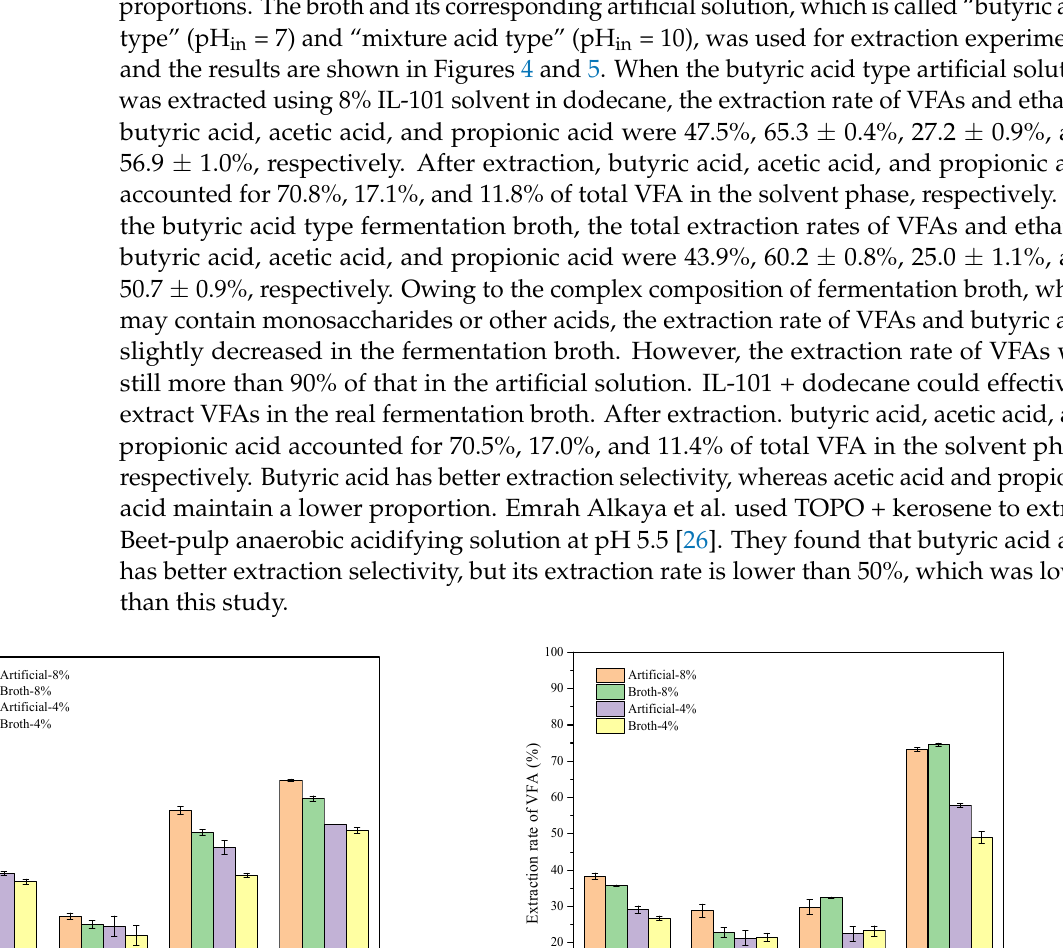
Figure 5. The composition of VFA in solvent phase after extraction. When the mixture acid type artificial solution was extracted using 8% IL ‐ 101 solvent in dodecane, the extraction rate of VFAs and ethanol, butyric acid, acetic acid, and propi ‐ onic acid were 38.4%, 73.3 ± 0.5%, 28.8 ± 1.9%, and 29.8 ± 2.1%, respectively. After extrac ‐ tion. butyric acid, acetic acid, and propionic acid accounted for 57.3%, 37.0%, and 3.9% of total VFA in the solvent phase, respectively. For the mixture acid type fermentation broth, the total extraction rate of VFAs and ethanol, butyric acid, acetic acid, and propionic acid were 35.7%, 74.6 ± 0.4%, 22.9 ± 1.3%, and 32.5 ± 0.1%, respectively. There was little loss of extraction efficiency in the fermentation broth. The extraction efficiency of butyric acid from real fermented broth was close to that in a previous report which used octanoic acid as extractant to extract single acid from artificial solution at pH 3 [39]. Compared with the butyric acid type fermentation broth, the extraction rate of total VFAs and ethanol from mixture acid type fermentation broth decreased by 17.9%, which may result from the higher concentration of VFAs and higher pH. However, the extraction rate of butyric acid was 1.4 times of that in butyric acid type fermentation broth. However, the proportion of acetic acid in the solvent phase reached 31.6%, whereas that of butyric acid decreased to 62.7%. This may be due to the higher concentration of acetic acid in broth, which was more than three times of that in the butyric acid fermentation broth. This shows that the concentration and type of VFAs in the fermentation broth can affect the